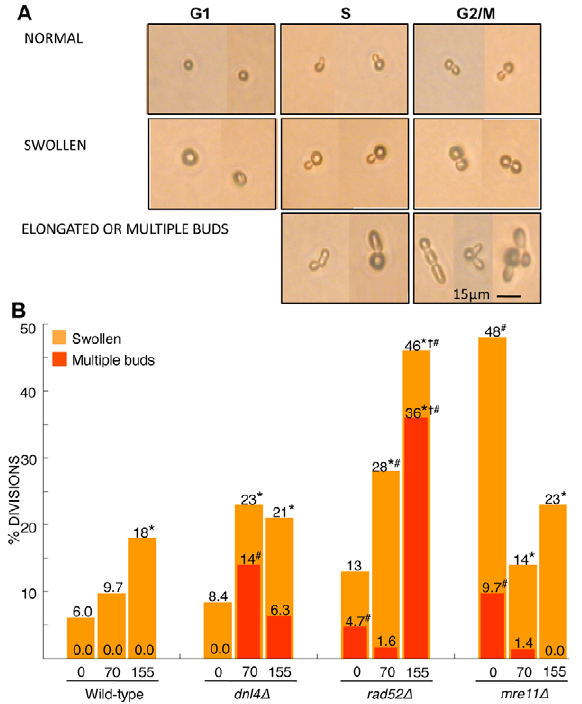
Figure 3. Analysis of cell swelling and morphological defects in CAG/CTG repeat-containing cells. (A) Representative micrographs of S. cerevisiae cells with expanded CAG-70 or -155 repeats experiencing an aberrant cell division cycle (G1, S or G2/M arrests) with either a swelling response or an abnormal morphology such as elongated or multiple buds. Cells undergoing a normal cell division cycle with normal morphology are included for comparison. The multibudded phenotype did not necessarily represent terminal arrests because cells were occasionally able to complete divisions despite this deformity. The size of swollen cells as quantified by NIH ImageJ software, was up to 5X the size of a normal cell; size correlated with length of the repeat and arrest duration. (B) Percent of divisions associated with swelling (light orange bars) or with both swelling and morphological defects (overlaid dark orange bars). Symbols as in Figure